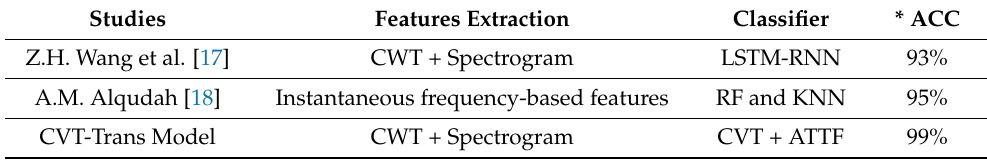
Figure 8. The confusion matrix for state-of-the-art techniques for classification of two categories of cardiovascular disease. Table 5. State-of-the-art classification results for categorizing five classes of PCG signals.